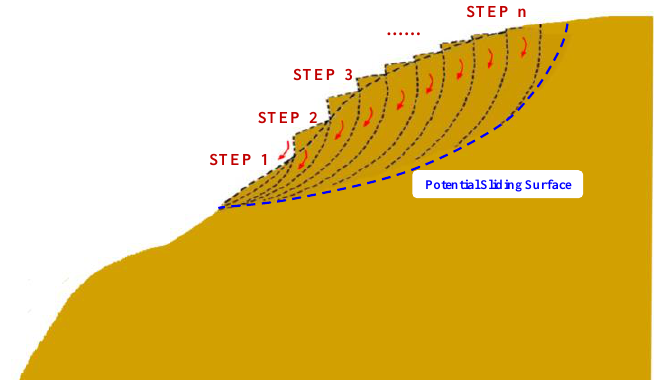
Figure 17. Schematic description of the progress of rotational landslides on red-bed slopes in South China.